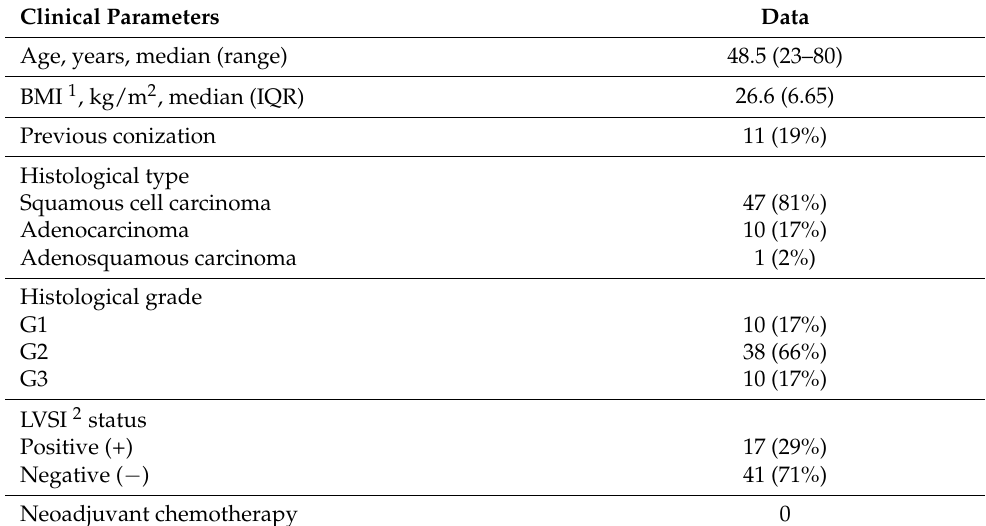
Table 2. Patients and disease characteristics ( n =